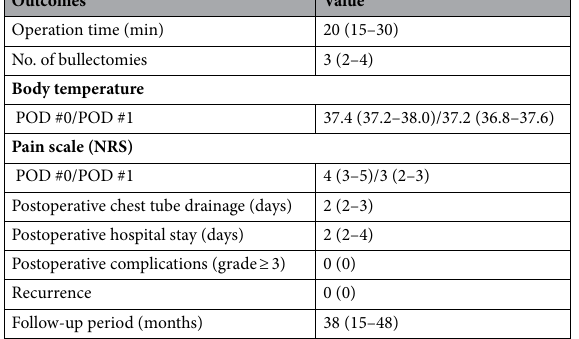
Table 2. Surgical and postoperative results. Data are presented as No. (%) or median (interquartile ranges). POD postoperative day, NRS numerical rating scale.